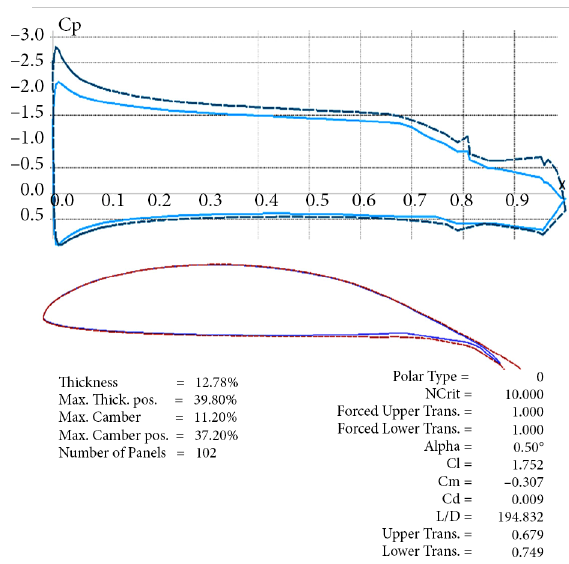
Fig. 4. Pressure distribution on the LAP 7-131/17 airfoil with a VGMF at a Re 1,1×10 6 (Figure: P. Lauk)